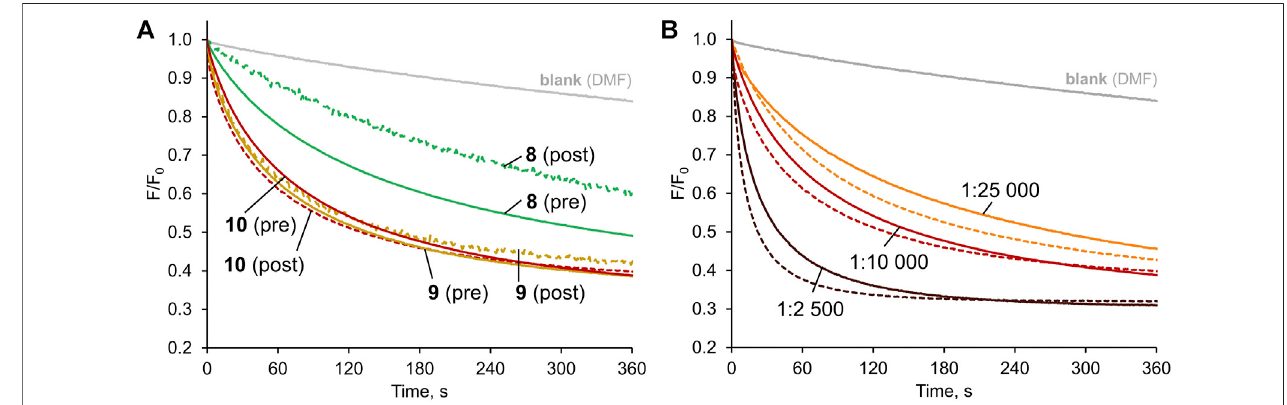
FIGURE 6 | Chloride transport with the anionophores either pre-incorporated in the membrane (solid lines) or added externally as a solution in DMF to vesicles without anionophore (dashed lines), mediated by: (A) 8 – 10 (1:10,000 transporter:lipids ratio); (B) 10 at various transporter:lipids